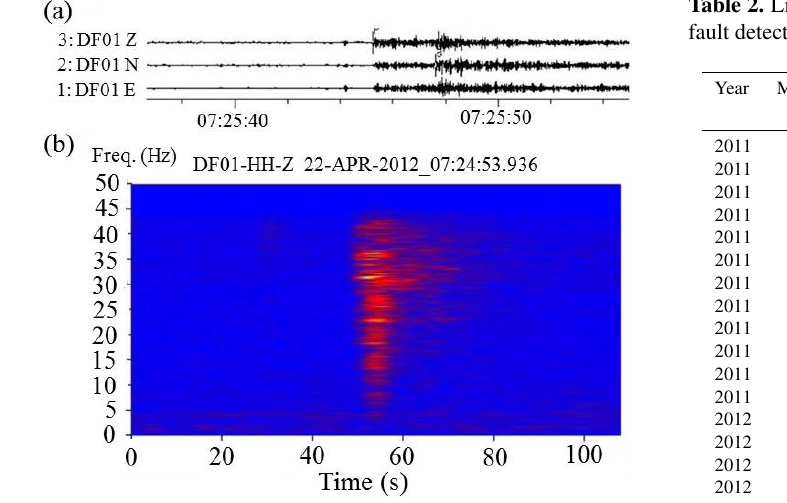
Figure 5. (a) Waveforms of a local earthquake on 22 April 2012, 07:25:41UT, at 67.8 ◦ N, 24.76 ◦ E, depth 5.8km recorded by DF01 station. (b) The spectrogram of the same event.